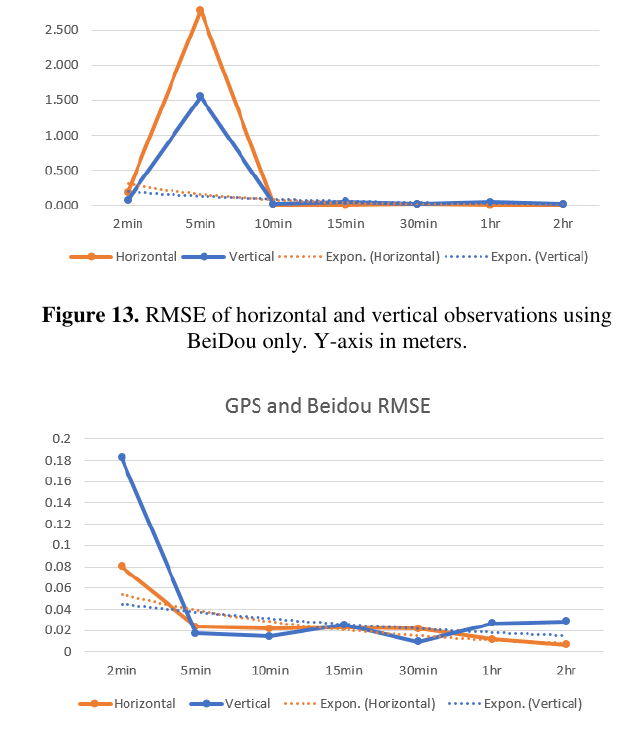
Figure 14. RMSE of horizontal and vertical observations using GPS and BeiDou satellites. Y-axis in meters.